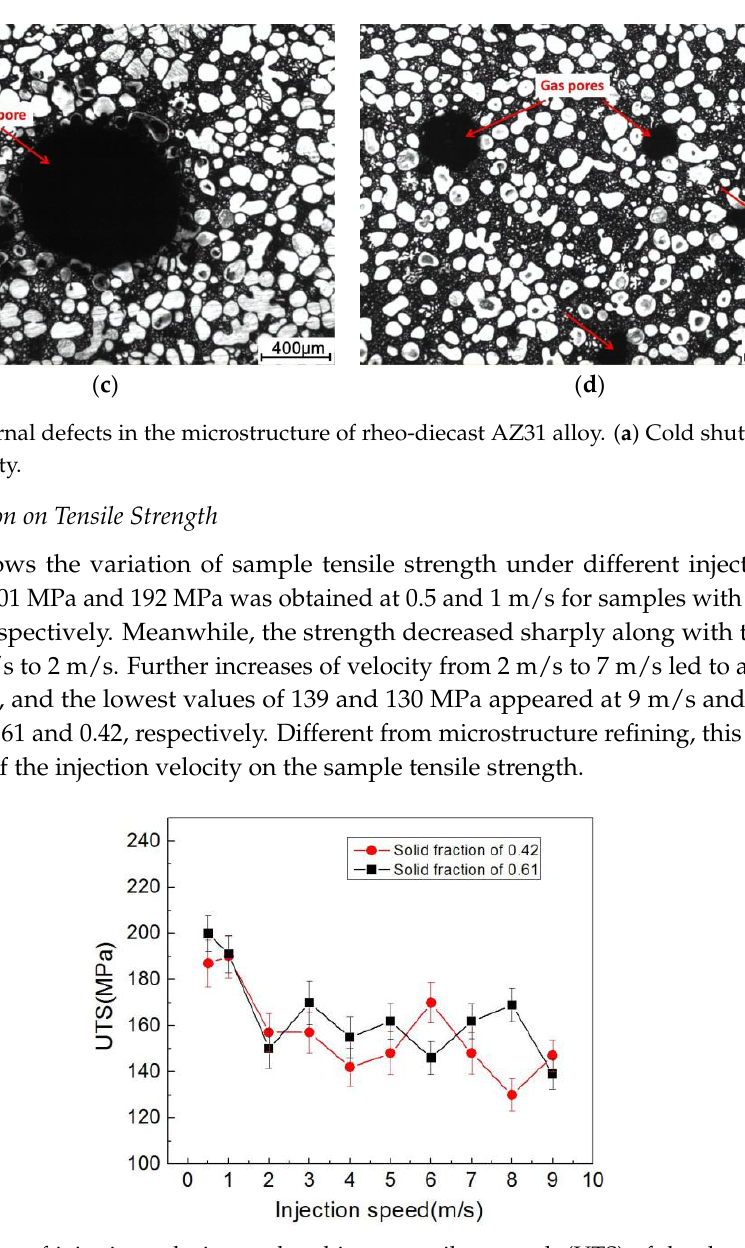
Figure 13. Effect of injection velocity on the ultimate tensile strength (UTS) of the rheo-diecasted AZ31 alloy.